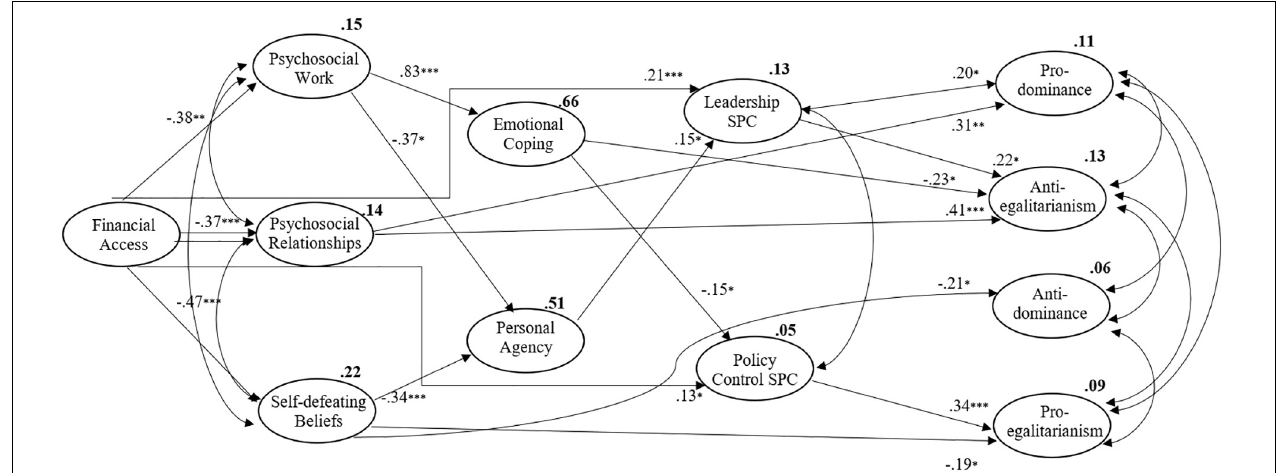
FIGURE 4 | Model B, representing significant effects; ∗∗∗ p < 0.001; ∗∗ p < 0.005; ∗ p < 0.05.